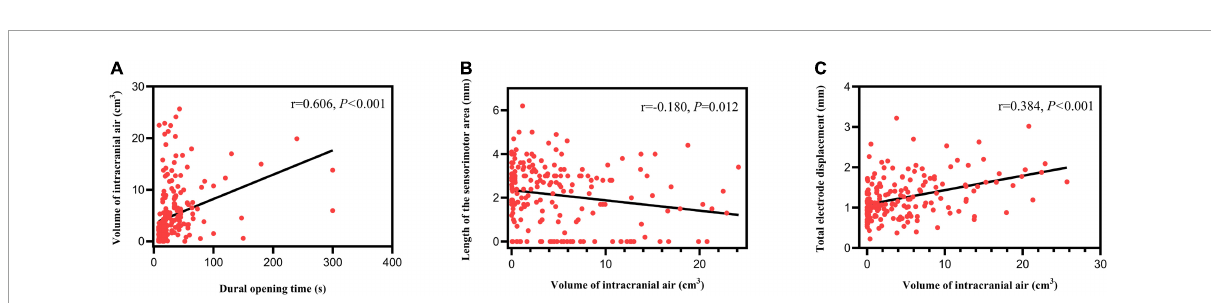
FIGURE5 Correlation analysis results. (A) The volume of intracranial air correlated positively with dural opening time. (B) Length of the sensorimotor area correlated negatively with the volume of intracranial air. (C) Total electrode displacement correlated positively with the volume of intracranial